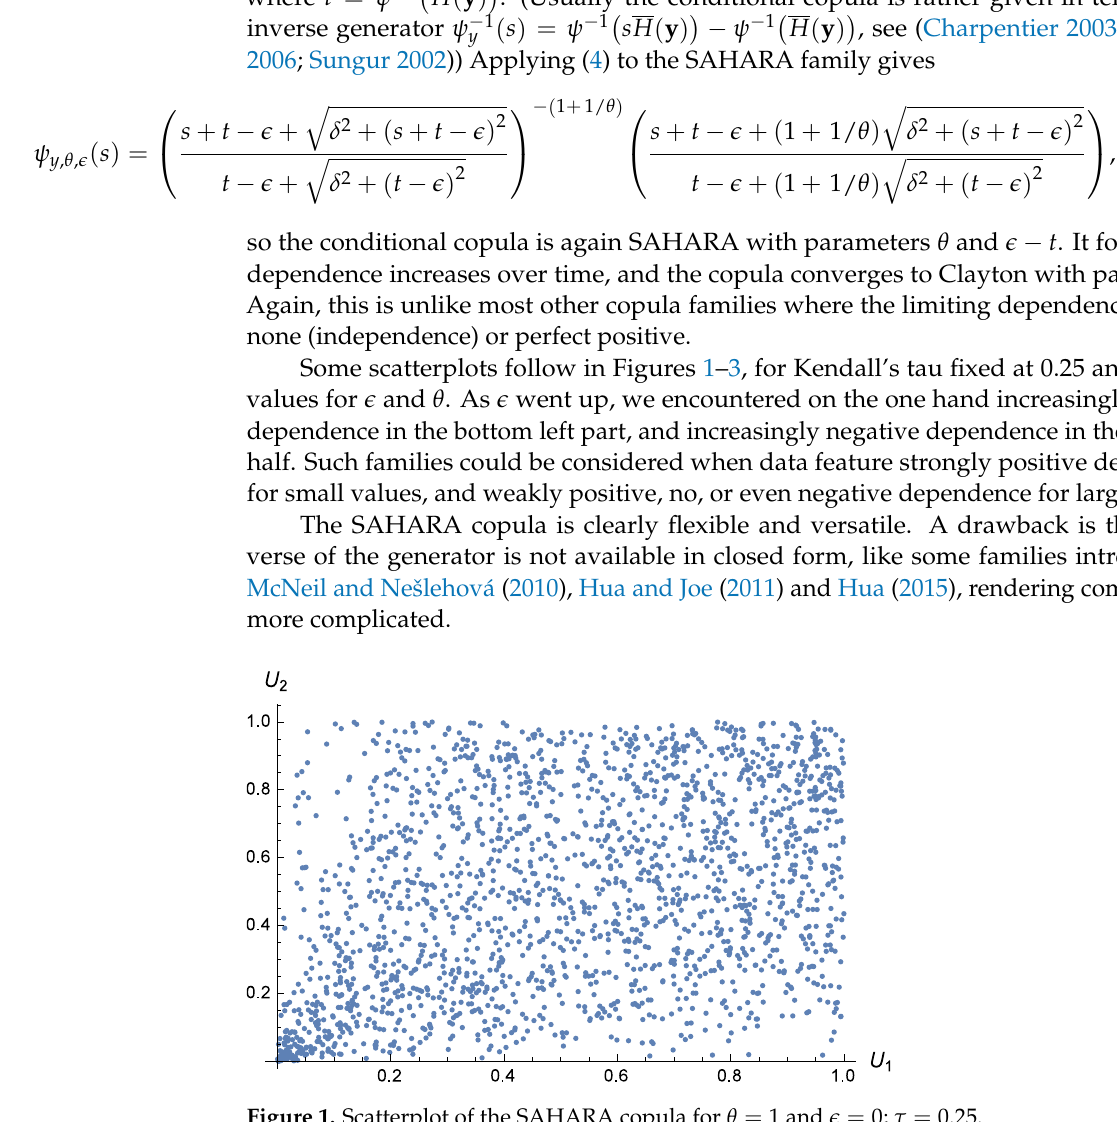
Figure 1. Scatterplot of the SAHARA copula for θ = 1 and (cid:101) = 0; τ =